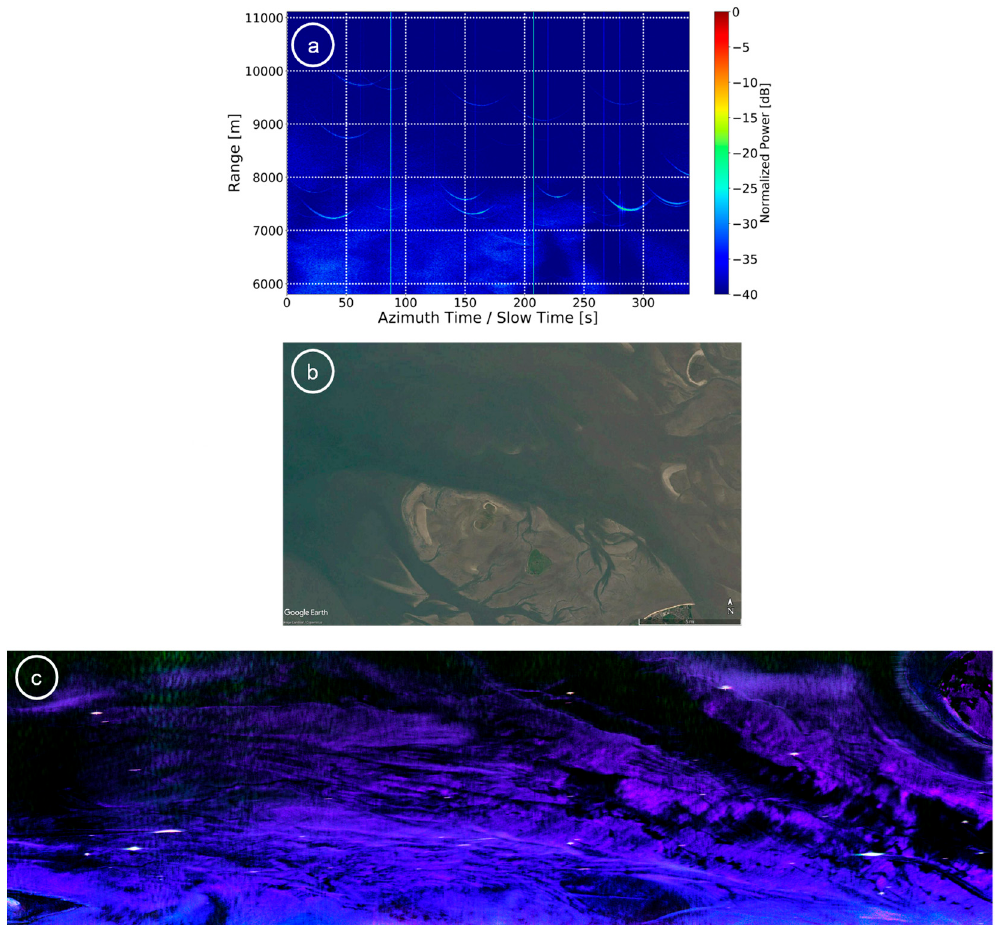
Figure 14. ( a ) RC radar data, ( b ) Google Earth image and ( c ) Pauli image corresponding to Figure 13a. Sandbanks can be clearly observed in the Google Earth image. The bright spots in the Pauli image are strong scatterers, e.g., buoys or ships.